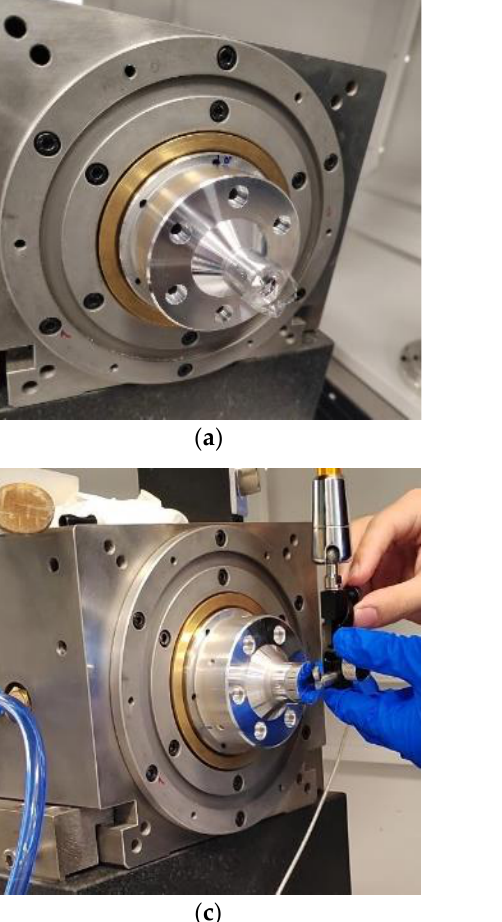
( b ) Figure 10. Donaldson reversal method measurement device: ( a ) before reversal, ( b ) after reversal. The measurement results are shown in Figure 11. The curves in Figure 11a – d show the synchronization error before reversal, the synchronization error after reversal, the roundness error of the standard workpiece and the radial error of the spindle, respec- tively. The radial error of the spindle is 25.135 nm, and the roundness error of the standard workpiece under testing is 20.515 nm. The measurement results based on the Donaldson reversal method are taken as the reference results. The measurement results obtained